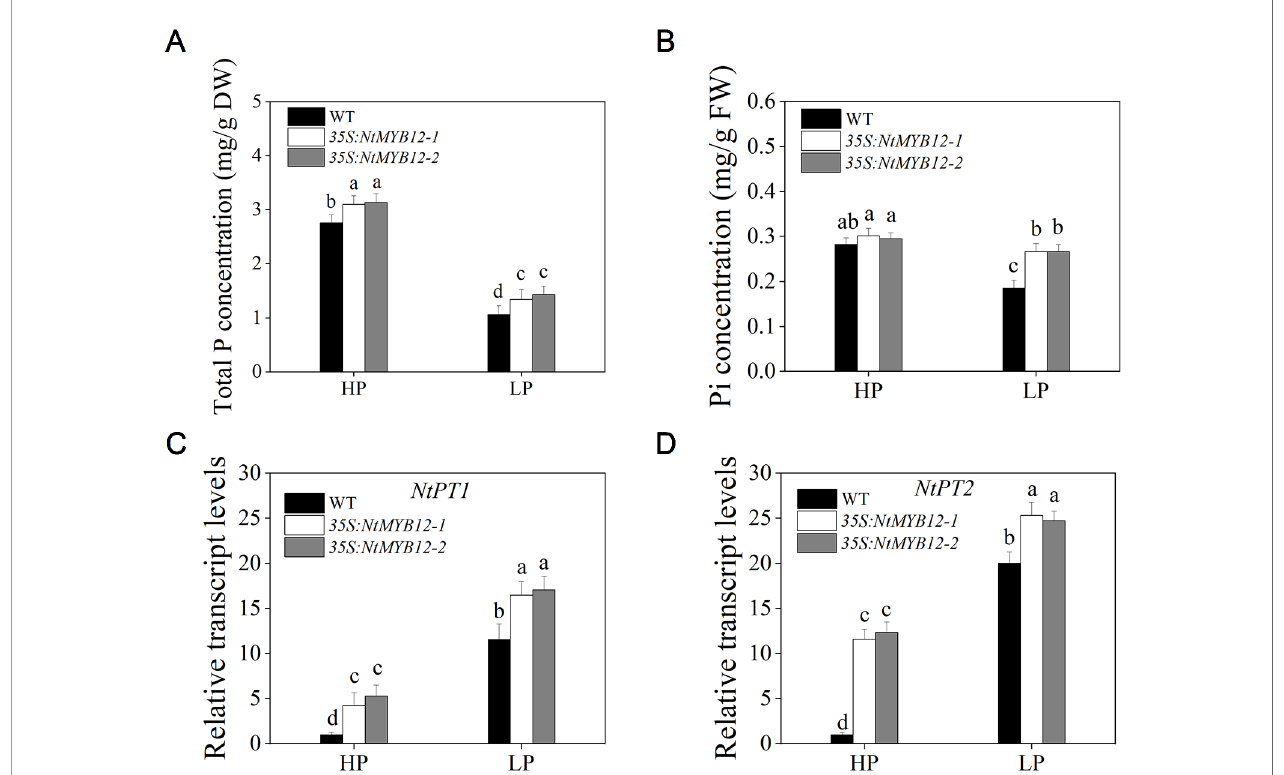
FIGURE 6 | Total P, Pi concentration, and relative transcript levels of two members of the tobacco Pht1 family in WT and 35S:NtMYB12 plants under HP and LP conditions. (A – B) Total P and Pi concentration of WT and transgenic plants in tobacco. (C – D) Effect of NtMYB12 overexpression on relative transcript levels of NtPT1 and NtPT2 in tobacco under HP and LP conditions. Sixteen-day-old seedlings were transferred to the full-strength culture solution and supplied with high Pi (HP; 1mM Pi) or low Pi (LP; 0.02mM Pi) for 21 days. The whole plants of the WT and transgenic plants were used for measuring Total P and Pi concentration and for RNA extraction. FW, fresh weight; DW, dry weight. Data are the means ± SDs of fi ve biological replicates. Different letters indicate signi fi cant differences ( P <